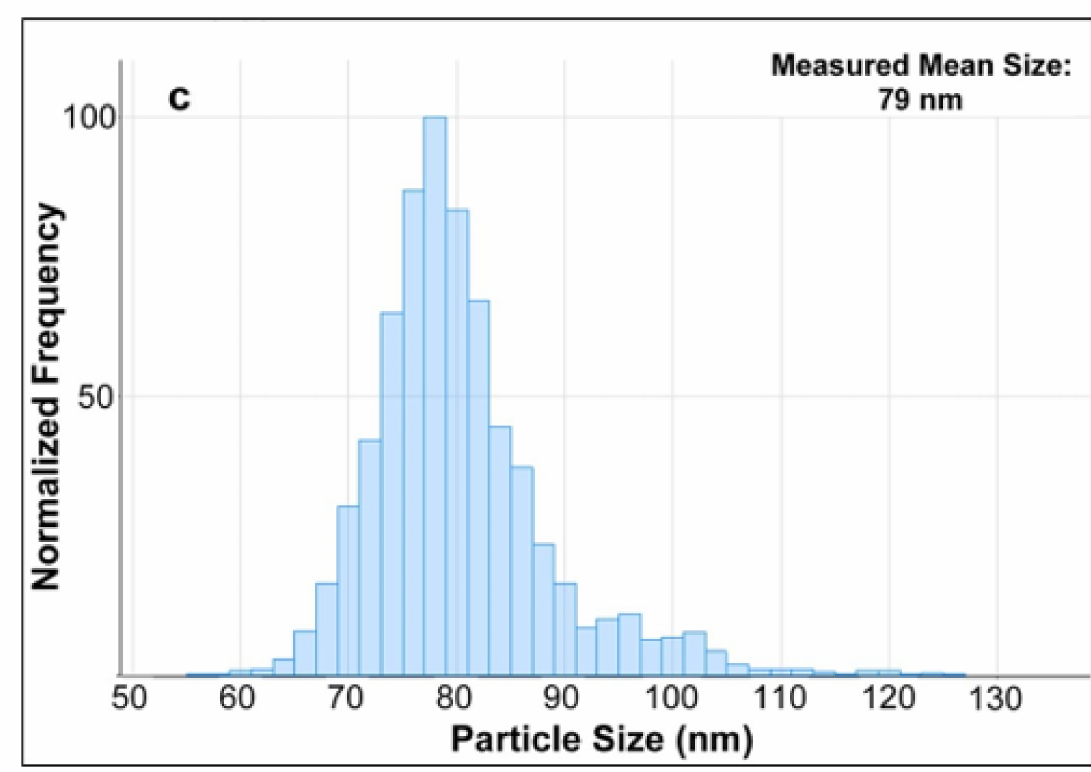
Figure 6. The experimental particles size distribution of AgNPs of ( a ) ~40 nm, ( b ) ~60 nm, and ( c ) ~80 nm spiked in the diluted enzymatic digest of milk, as measured by SP-ICP-MS